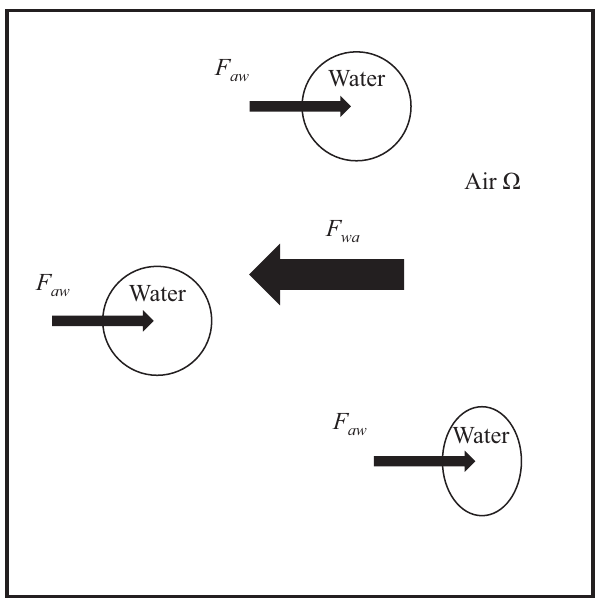
Figure 5. The force diagram of droplets and air in the